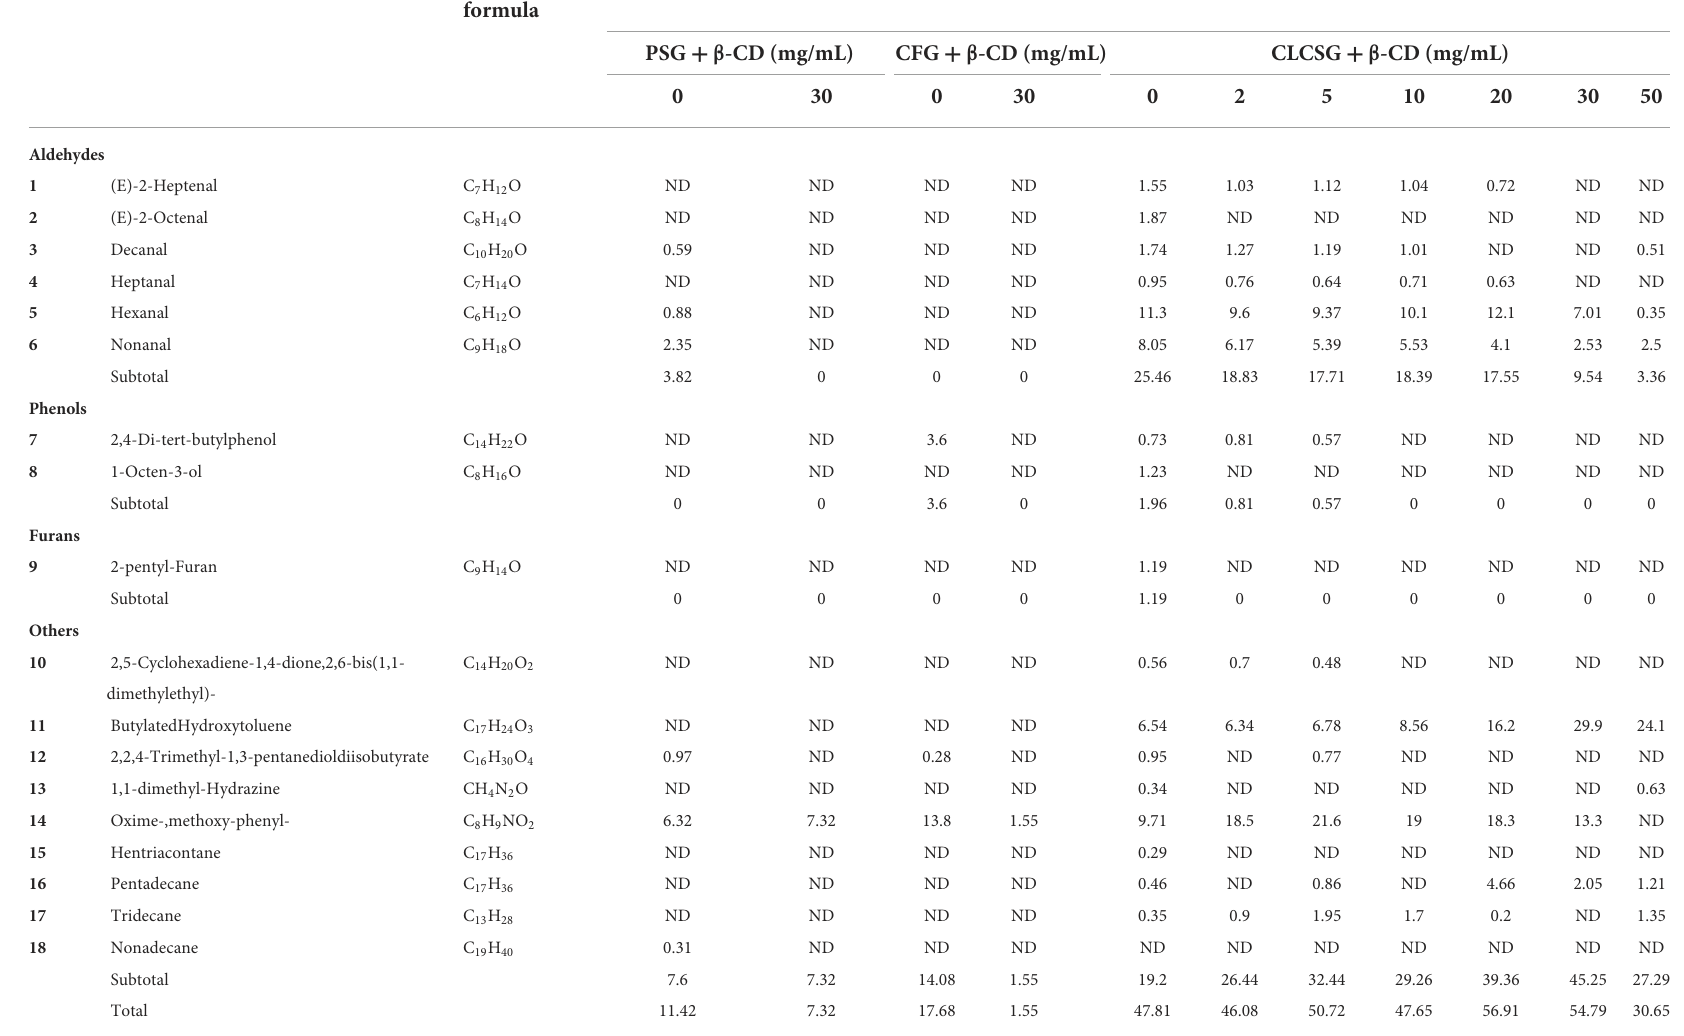
TABLE 1 Volatile substances of gelatins (PSG, porcine skin gelatin; CFG, cold-water fish skin gelatin; and CLCSG, Chinese longsnout catfish skin gelatin; 66.7 mg/mL) with β -cyclodextrin ( β -CD, 0–50 mg/mL) identified using gas chromatography-mass spectrometry.